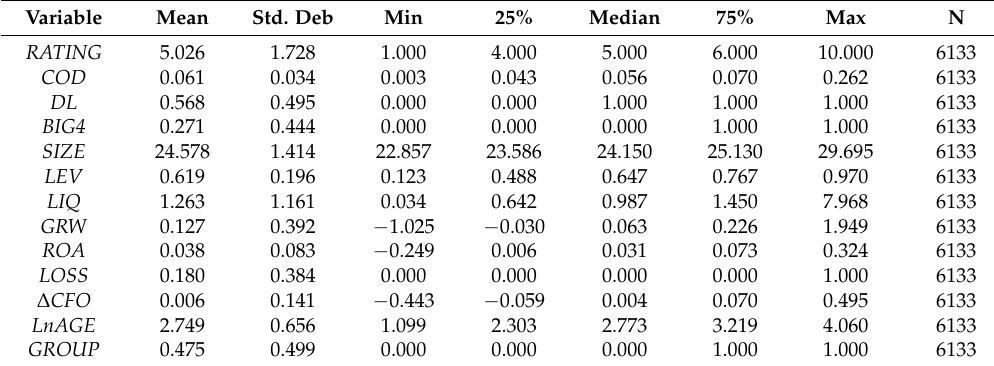
Table 2. Descriptive statistics (sample period =